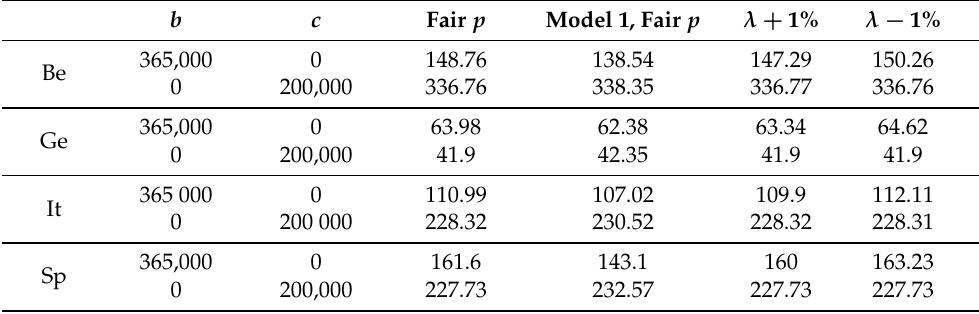
Figure 3. Comparison of E ( I t |F 0 ) with the observed values and those computed with the determin- istic model of Section 6. Table 7. Fair premium rates with the model in (1). Duration T = 0.5 year and r = 2%.